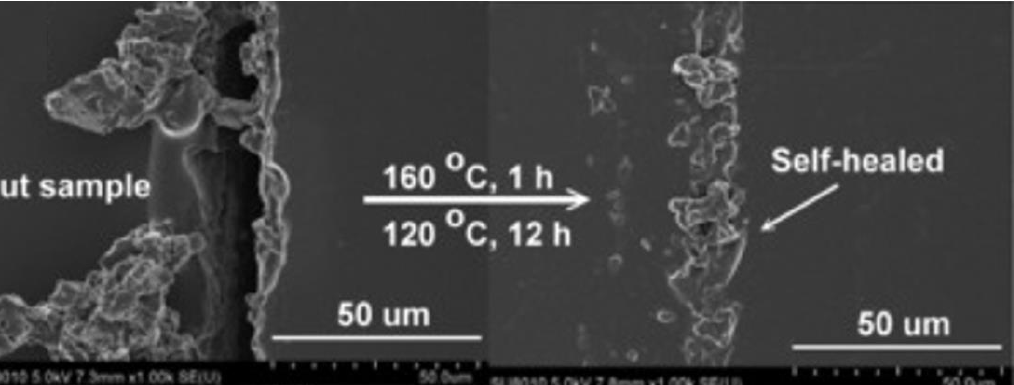
Figure 23. SEM micrographs of MMA-POSS/FA films before and after self-healing at 160 °C for 1 h and at 120 °C for 12 h . Reprinted from Compos. Sci. Technol . 2015, 118 , Chuo, T.-W.; Liu, Y.-L., Prep- aration of self-healing organic-inorganic nanocomposites with the reactions between methacrylated polyhedral oligomeric silsesquioxanes and furfurylamine, 236 – 243, [84]. Copyright (2015), with per- mission from Elsevier.